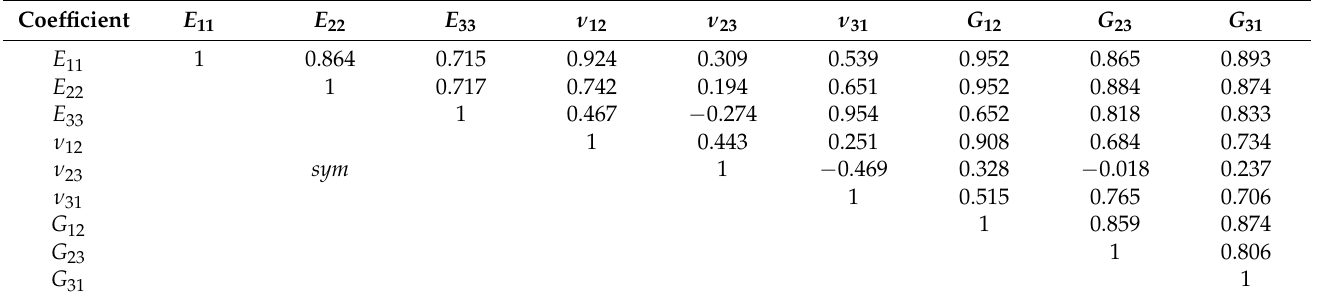
Table 8. The correlation coefficients between equivalent parameters of 2D braided